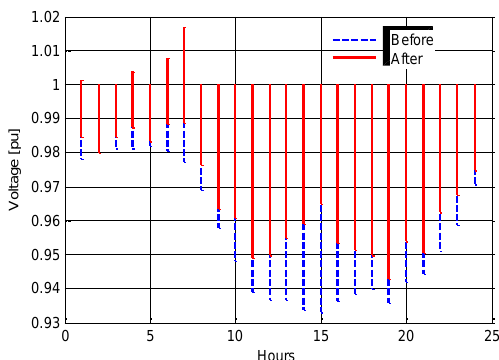
Figure 17. Voltage profile for 24 h (second scenario).